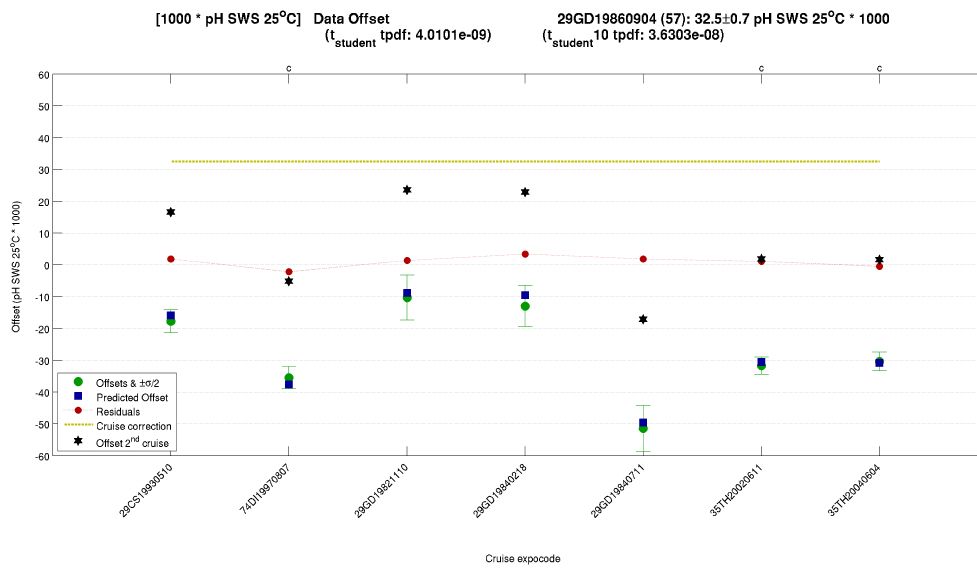
Figure 12. Cruise crossover information plot for 29GD19860904 (57).